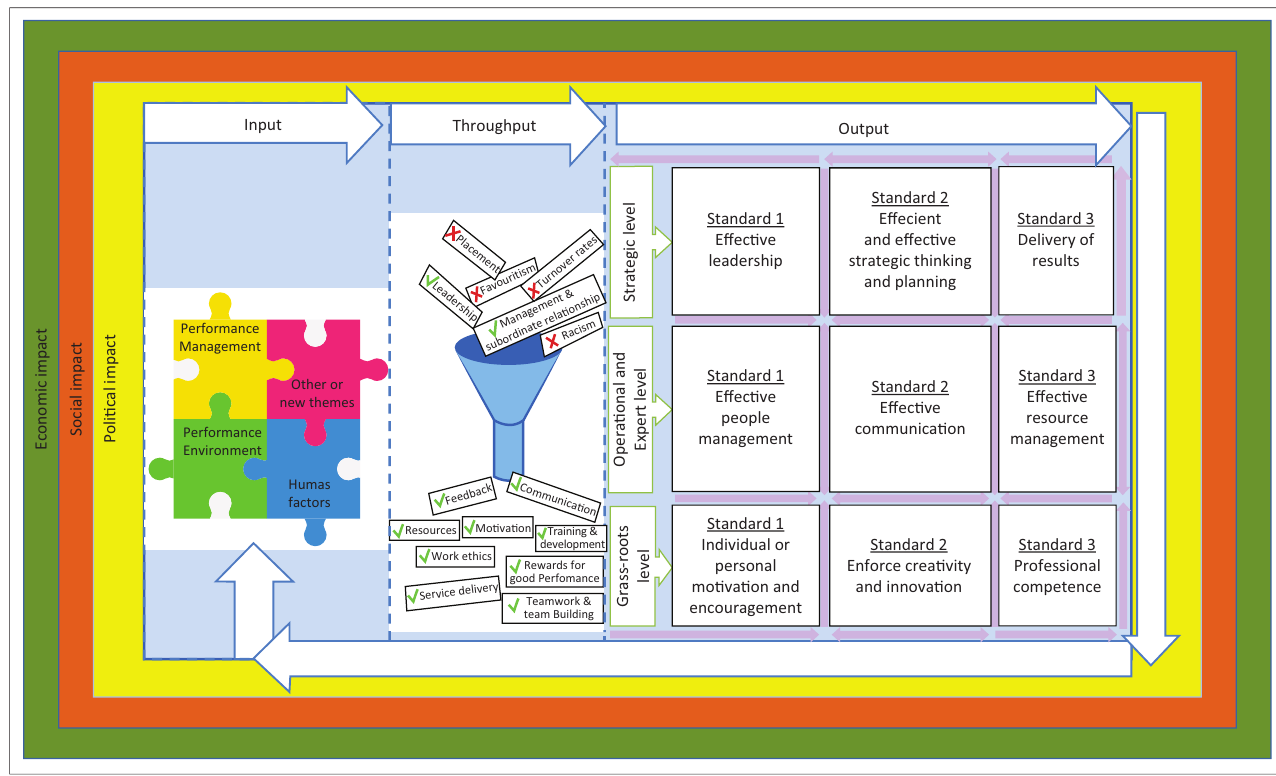
FIGURE 9: Input–throughput–output